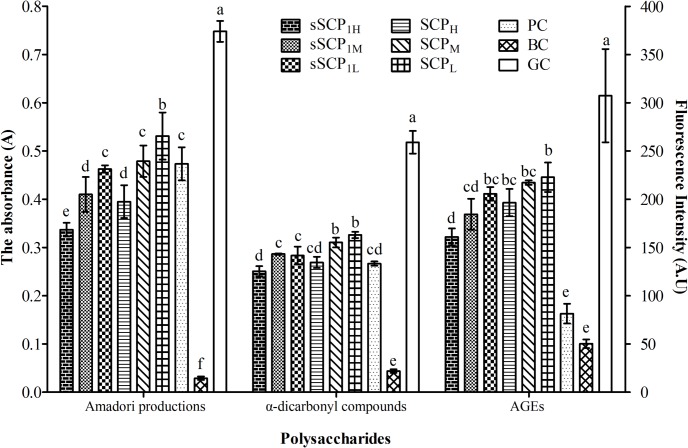
The absorbance of Amadori products and α-dicarbonyl compounds and the relative fluorescence intensities of AGEs in each group.[sSCP1L = BSA+Glu+sSCP1 (0.25mg·mL-1); sSCP1M = BSA+Glu+sSCP1 (0.5mg·mL-1); sSCP1H = BSA+Glu+sSCP1 (1mg·mL-1); SCP L = BSA+Glu+SCP (0.25mg·mL-1); SCPM = BSA+Glu+SCP (0.5mg·mL-1); SCPH = BSA+Glu+SCP (1mg·mL-1); PC = BSA+Glu+AG; BC = BSA+PBS; GC = BSA+Glu]. Bars in same concentration without same superscripts (a–f) differ significantly (P < 0.05).